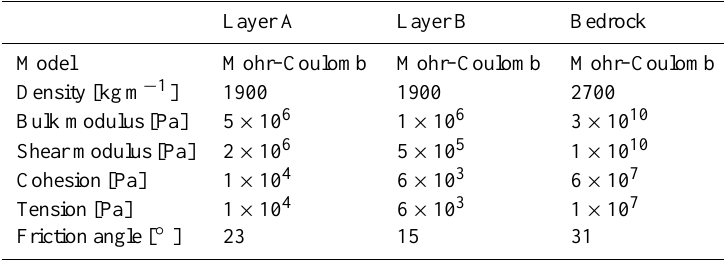
Table 1. Soil properties which lead to slope failure under fully saturated conditions.